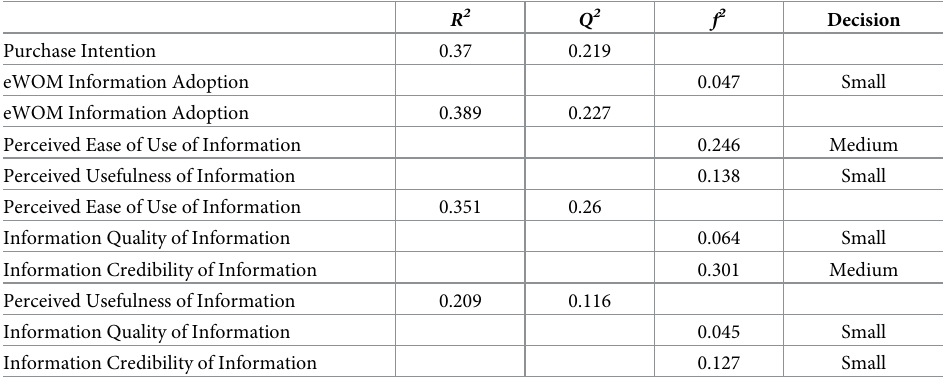
Table 5. Predictive relevance Q 2 , effect sizes (f 2 ), and coefficient of determination R 2